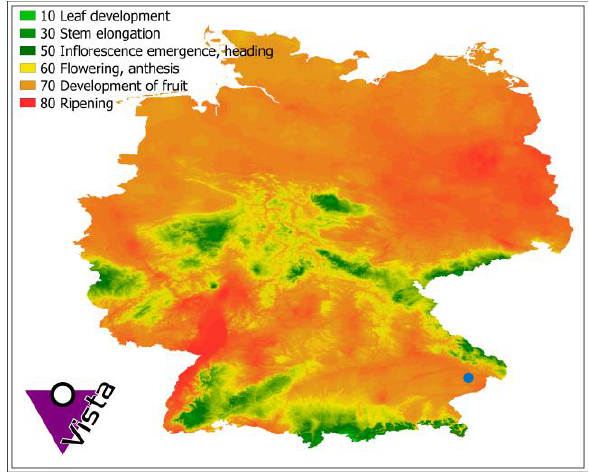
Figure 5. Simulated phenological stages for maize in Germany for the 5 th August 2014 illustrating the heterogeneity of crop development (blue spot indicates location of